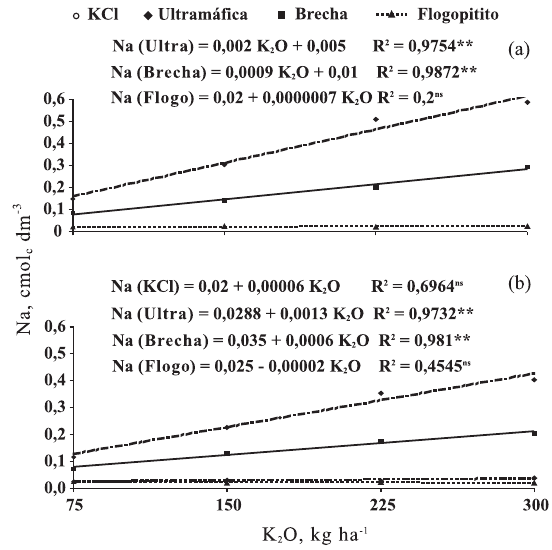
Figura 3. Sódio trocável no solo após incubação de 45 dias (a) e após cultivo de soja